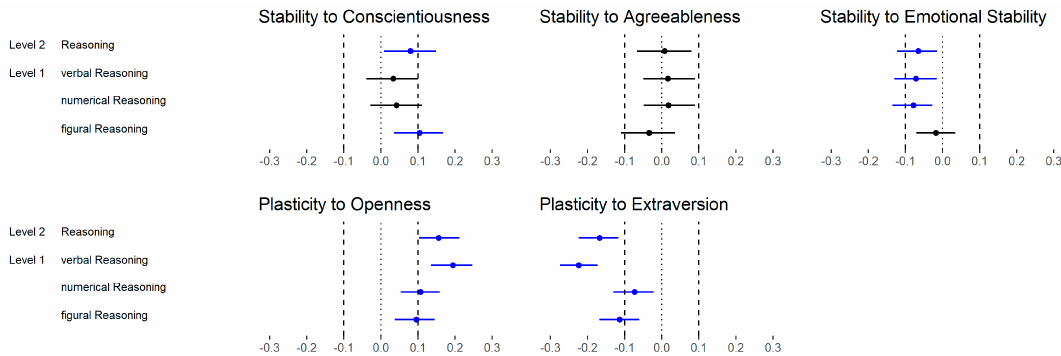
Figure 8. Study 1: Evaluation of the Brunswik Symmetry principle with regard to personality. Change of correlations when FFM dimensions (medium level) were considered instead of Stability and Plasticity (Big Two; high level). Blue lines indicate substantially different correlations based on an equivalence testing approach.